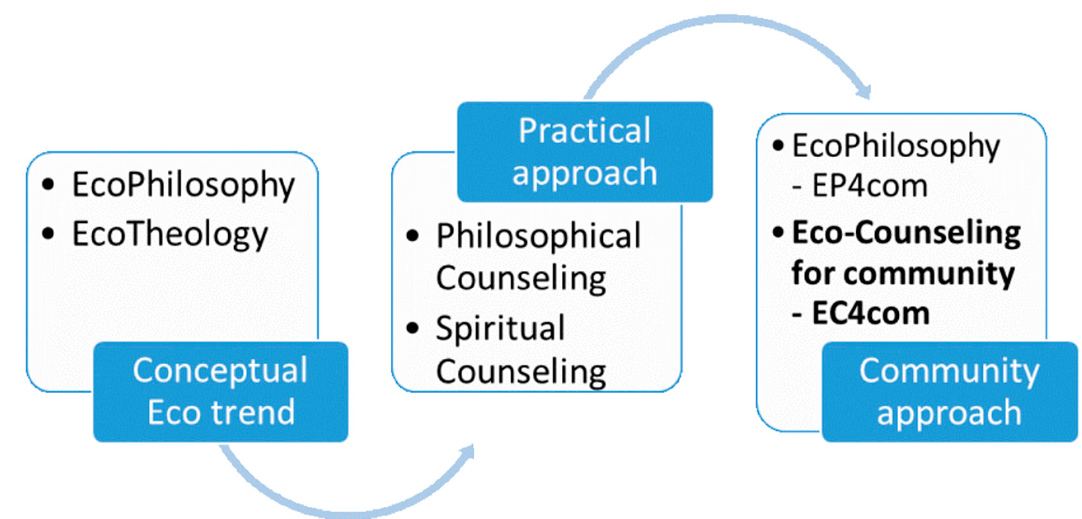
Figure 1. Connections between the trends developed by both areas analyzed.